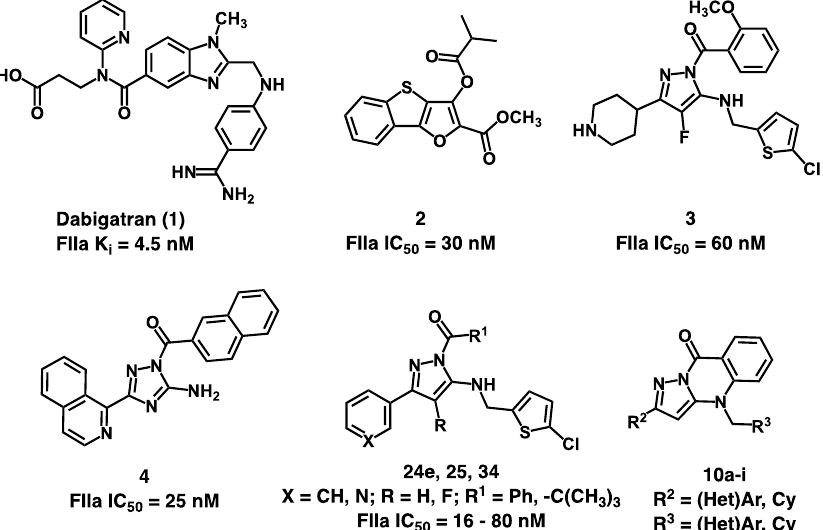
Figure 1. Exemplary structures of small molecule thrombin (FIIa) inhibitors. Dabigatran ( 1 ) [4] is a non-covalent direct thrombin inhibitor, compounds 2 – 4 [14–16] are covalent serine-trapping thrombin inhibitors. Potential inhibitors 24e , 25 , 34 , and 10 developed in this work.